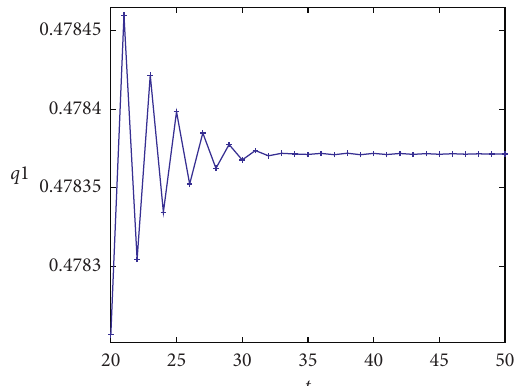
Figure 14: The quantity fluctuations of manufacturer